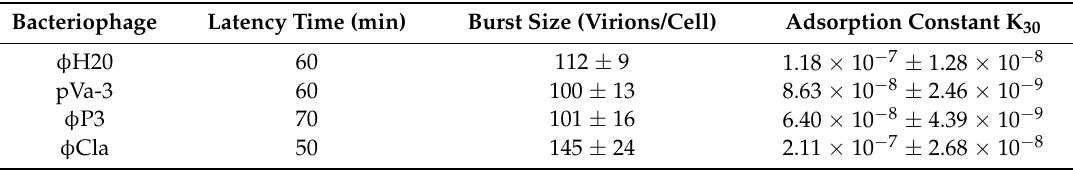
Table 2. Kinetic parameters (latency time, burst size and adsorption constant) of the bacteriophages φ H20, pVa-3, φ CLA and φ P3. All values are means ± standard deviation of three independent